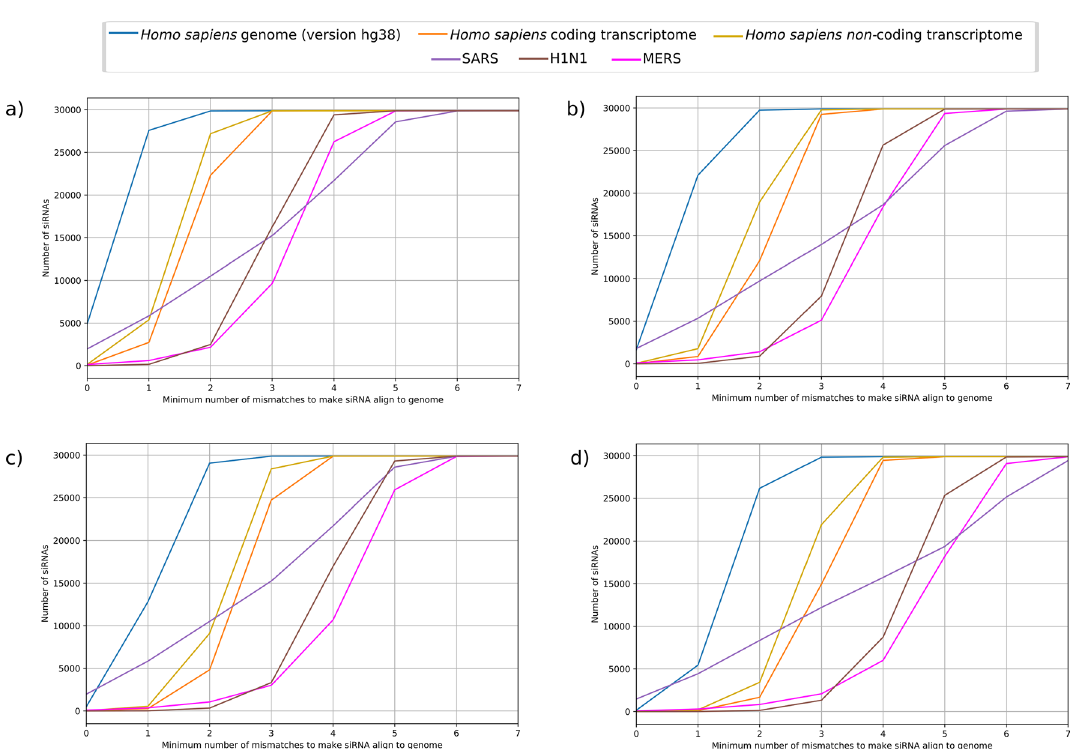
Figure 2. Number of mismatches against Human genome and transcriptomes. The number of antisense ( a ) 18nt-long, ( b ) 19nt-long, ( c ) 20nt-long, and ( d ) 21nt-long siRNAs with different mismatches against Human genome, Human coding and non-coding transcriptome, and MERS, SARS, and H1N1